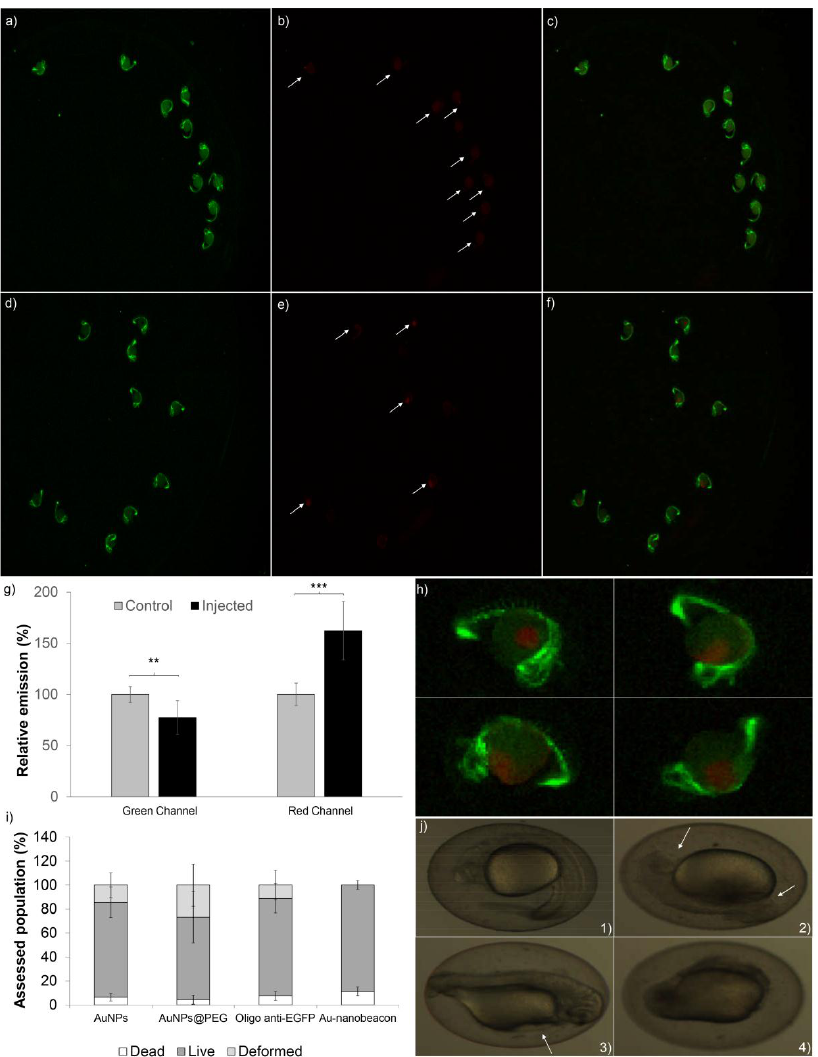
Figure 2. Au-nanobeacon silencing efficiency of the enhanced green fluorescence protein (EGFP) and acute toxicity assessment. Fluorescence imaging of whole embryos after injection (amplification 8.1×); ( a ) Green channel of control embryos; ( b ) Red channel of control embryos; ( c ) Merged channels for control embryos; ( d ) Green channel of injected embryos; ( e ) Red channel of injected embryos; ( f ) Merged channels for injected embryos (8.1× amplification); ( g ) Quantification of fluorescence in whole embryos using Image J. The results were normalized to the respective channel of the control. The data are expressed as mean ± standard deviation of five embryos (sample t test—*** for p <